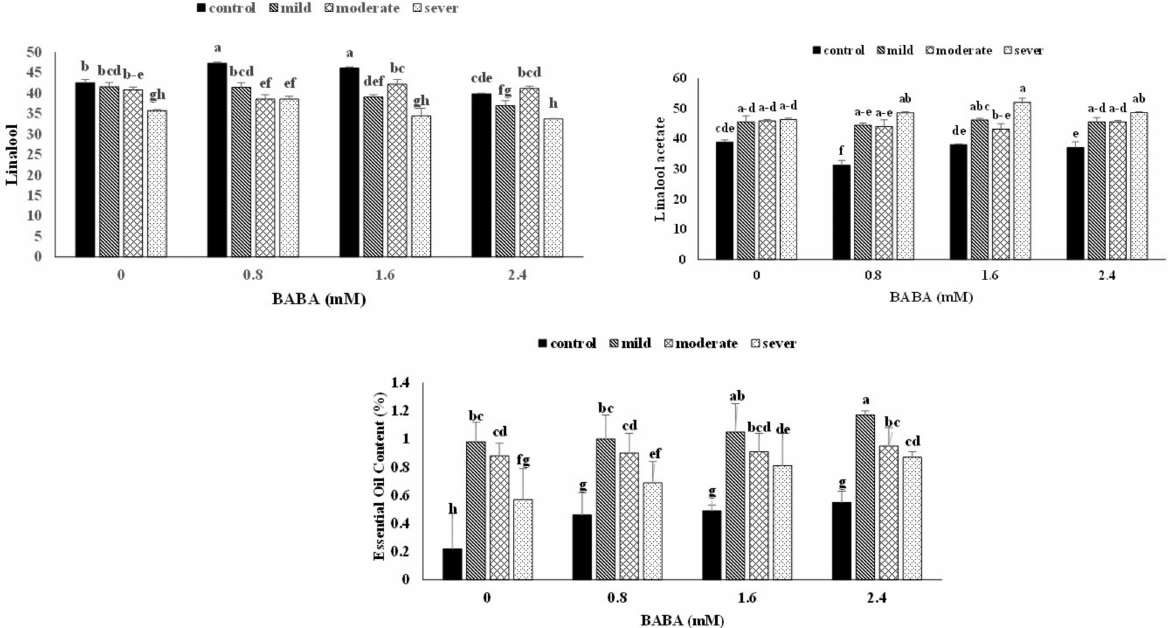
Figure 1. Content of grapefruit mint essential oil, and percentages of linalool, and linalool acetate under different levels of water stress and foliar applications of BABA. Data are means of three independent replications (n = 3). Data shown are mean values of n = 3 and the error bars represent standard errors of the means. Different letters indicate significant differences ( p < 0.05) among the treatments (LSD test at 5%